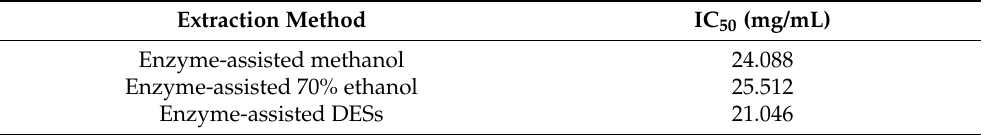
Table 4. IC 50 of the different extraction